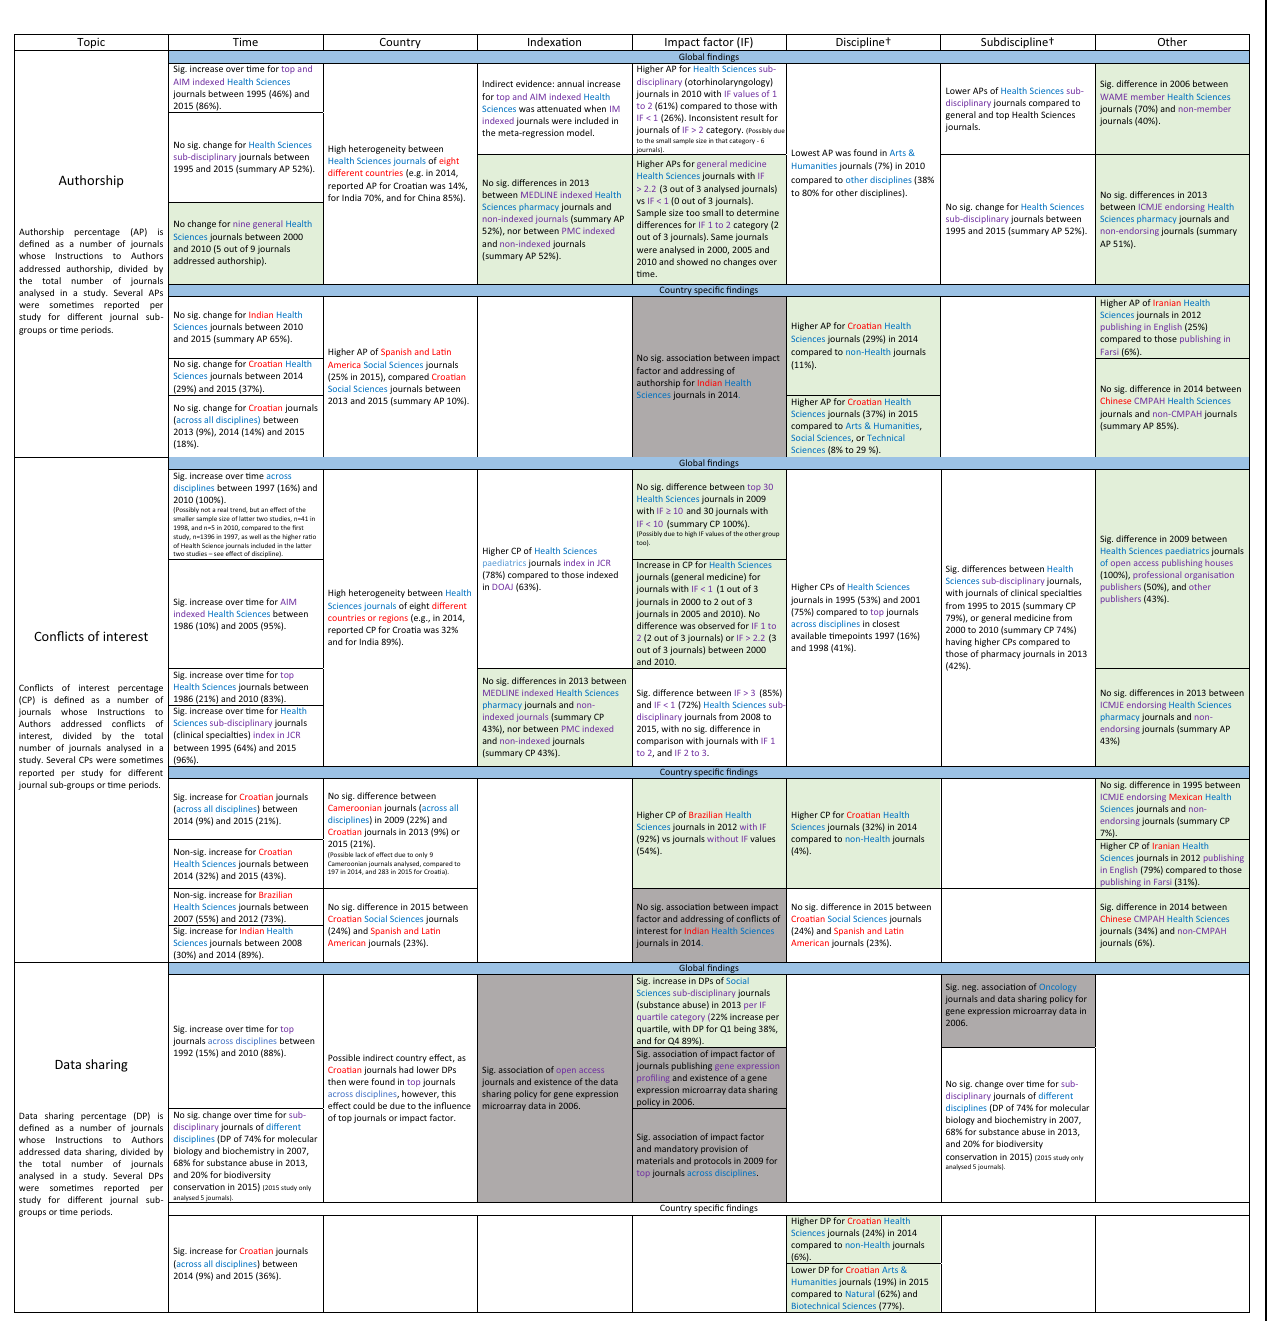
Table 3 Factors associated with addressing of topics in journals ’ Instructions to Authors (ItAs). Factors were con fi rmed by meta- regression or by demonstrating signi fi cant differences when data were obtained from up to three studies (white background) , calculated from data reported in individual studies (green background) or reported as presented in individual studies, i.e., data reported in a way that did not allow calculation (grey background) . All associations are presented only descriptively, with full details and 95% CIs available in the Supplementary Information. We used additional colouring to highlight disciplines (blue) , countries (red) , and other categories (purple)